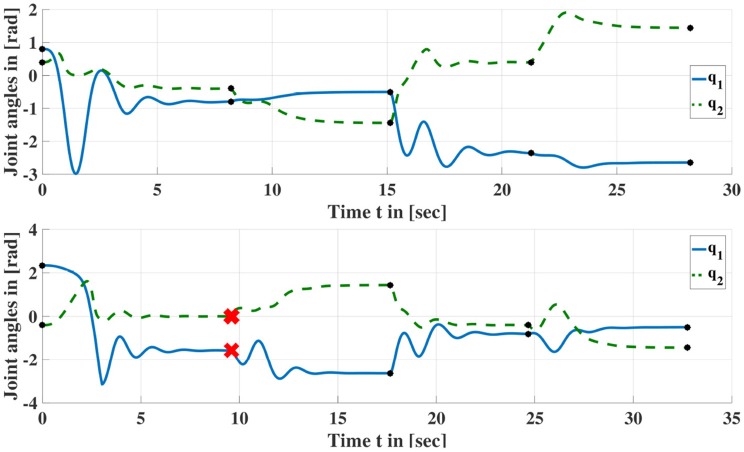
Joint trajectories resulting from applying sequences of torque profiles according to Figure 3. Red crosses indicate that the joint limits have been reached and the manipulator returned to its home configuration. Black dots indicate the end of a profile where τipr[nsi] is applied until the manipulator has settled down in this configuration i.e., the manipulator has stopped moving. The corresponding configurations are entered into Lτ′ (cf. Algorithm 1).